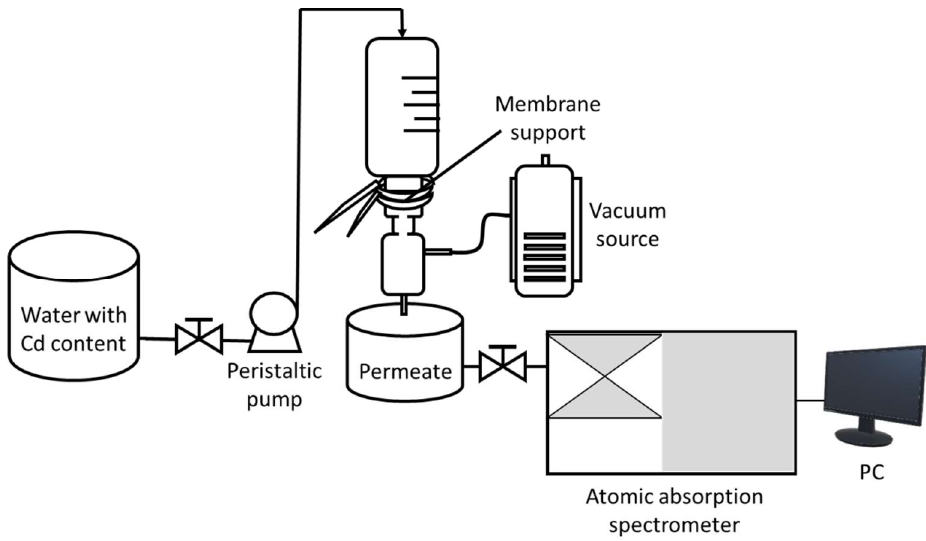
Figure 1. Schematic representation of the ultrafiltration test cell of water with cadmium